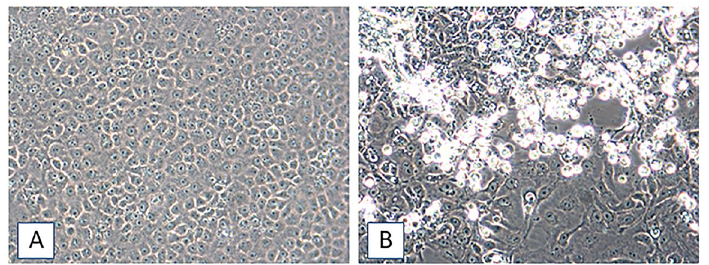
Fig 2. Madariaga virus– induced CPE in Vero E6 cells, 23 dpi. [A]. Mock-infected Vero E6 cells, 23 days post-seed. [B]. Vero E6 cells inoculated with plasma sample 1–1901. Infected cells develop dark, granulated cytoplasms with inclusion bodies, the cells enlarge, and dead cells detach from the growing surface. Images taken at an original magnification of